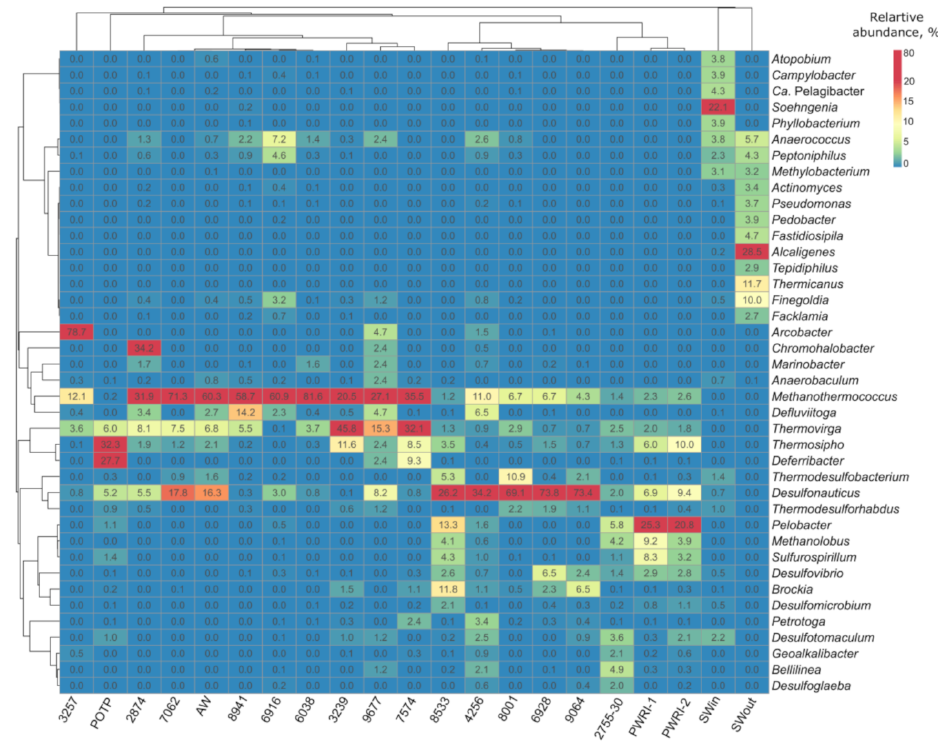
Figure 2. Heatmap of the 40 genera with the highest relative abundance in the libraries of the 16S rRNA gene sequences from injection and production water samples from the Uzen oil field. Representation of the genus was calculated as sequence proportions divided by total sequence count in each library. Columns are clustered using correlation distance and average